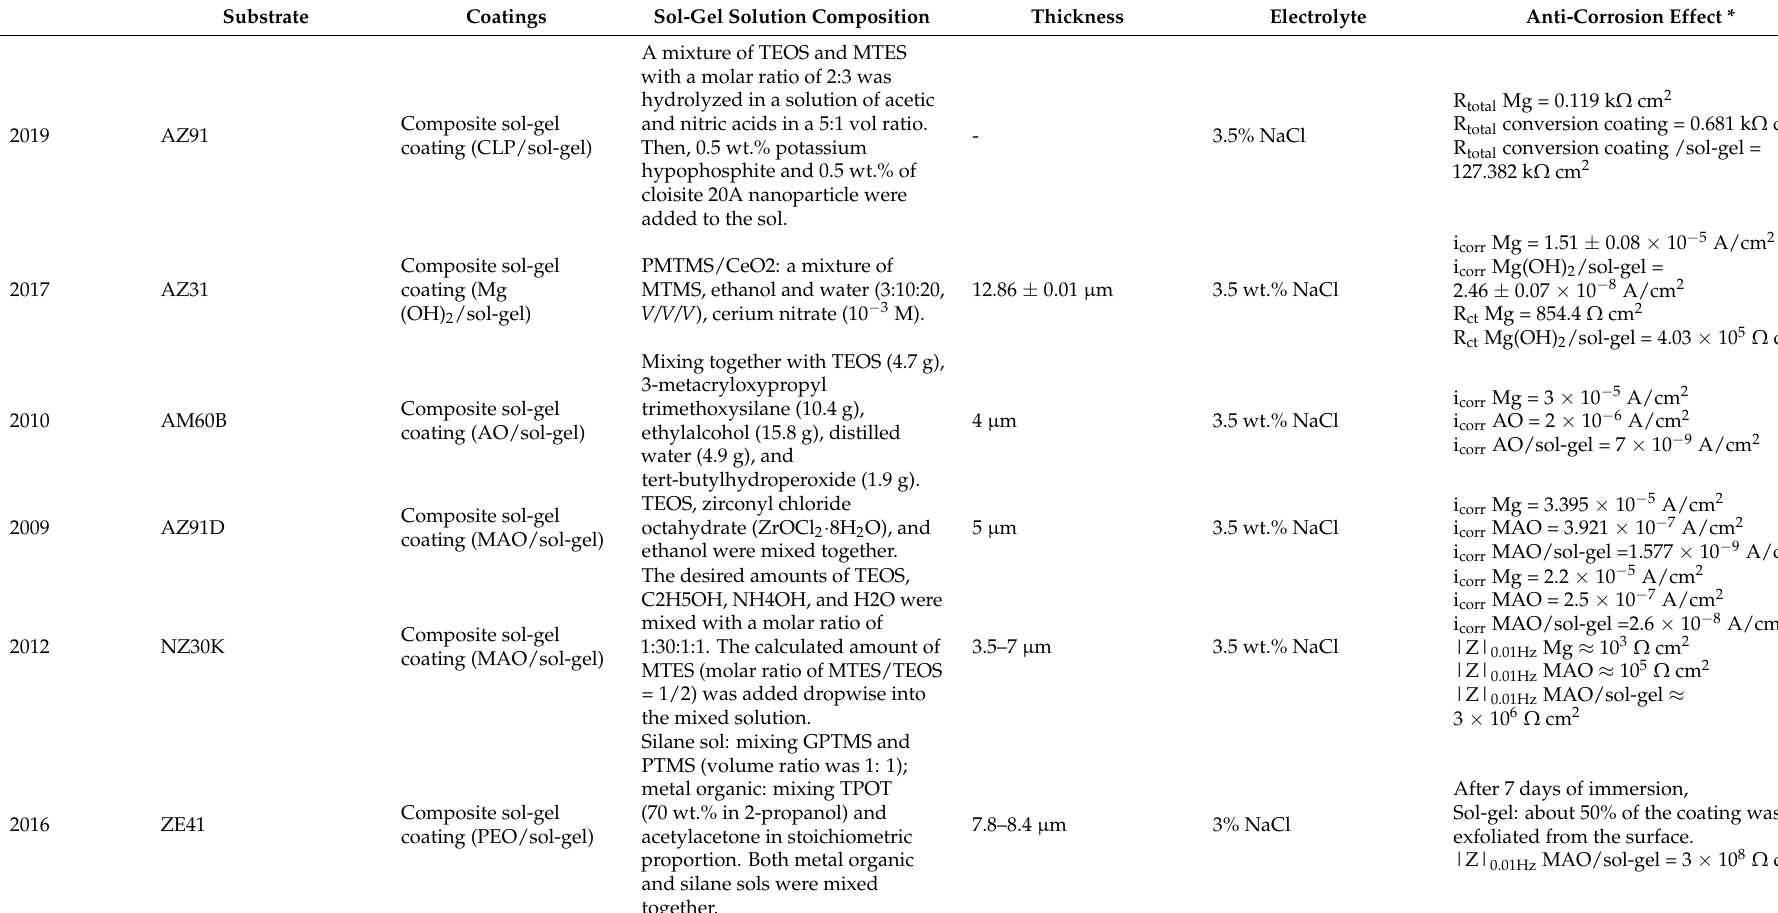
metal organic: mixing TPOT (70 wt.% in 2-propanol) and acetylacetone in stoichiometric proportion. Both metal organic and silane sols were mixed